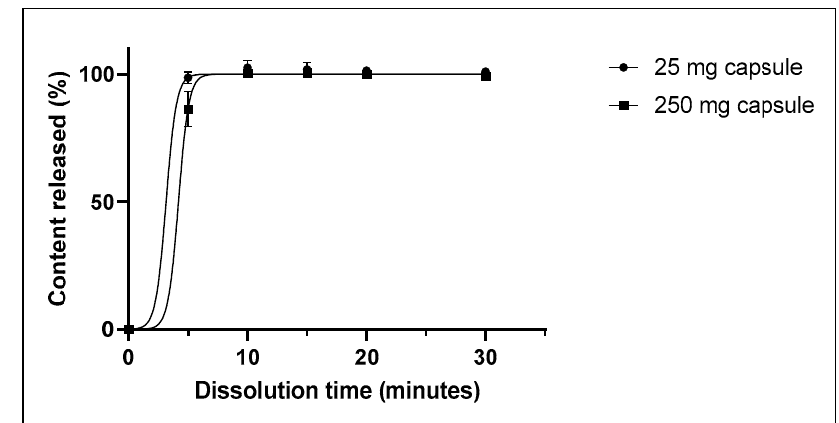
Figure 1. Dissolution profiles of 25 mg and 250 mg CA capsules (mean ± SD, n = 3).